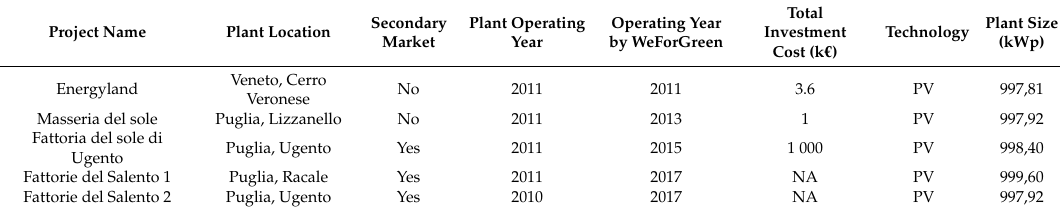
Table 5. Projects developed by WeForGreen.